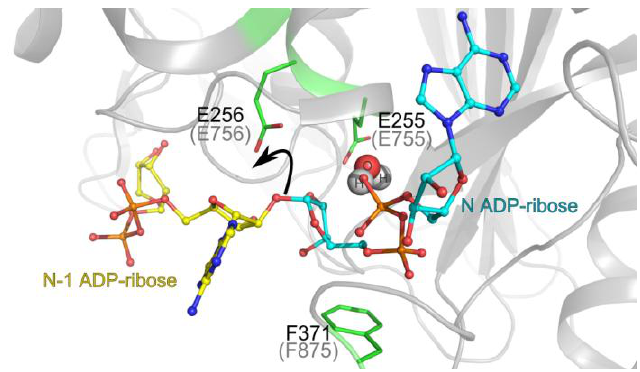
Figure 3. PARG catalytic mechanism. The positions of the reaction product N ADP-ribose (teal backbone; observed in the crystal structure) and a model of N-1 ADP-ribose (yellow) are represented in the Tetrahymena thermophila PARG active site. The key O -glycosydic ribose-ribose bond is positioned in direct hydrogen bonding contact with the catalytic glutamate 256 (Glu756 in human PARG; grey brackets). The 2’-OH leaving group of n-1 ADP-ribose’ is protonated (black arrow) by the catalytic glutamate. A subsequently formed oxocarbenium intermediate is stabilised by the close proximity of the terminal diphosphate group, which is restrained by the conserved phenylalanine 371 (Phe875 in human PARG). A water molecule (shown in spheres) is ideally positioned to attack this oxocarbenium intermediate. This leads to release of